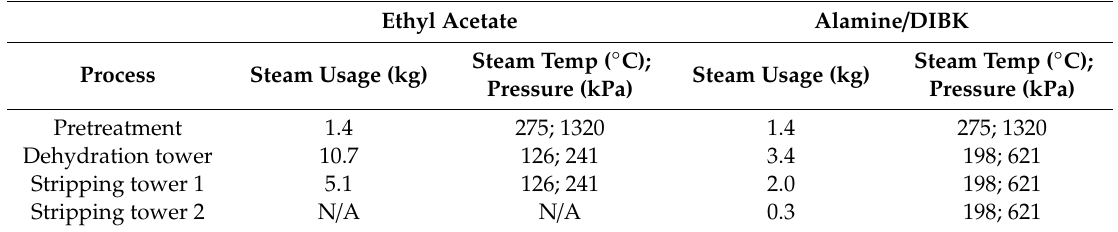
Table 3. Major biorefinery unit operation steam uses per kg of acetic acid produced.